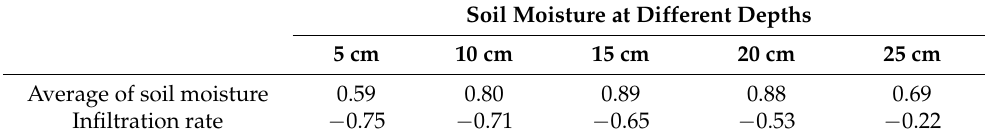
Table 1. Correlation coefficient of average of soil moisture and infiltration rate with soil moisture at different depths.